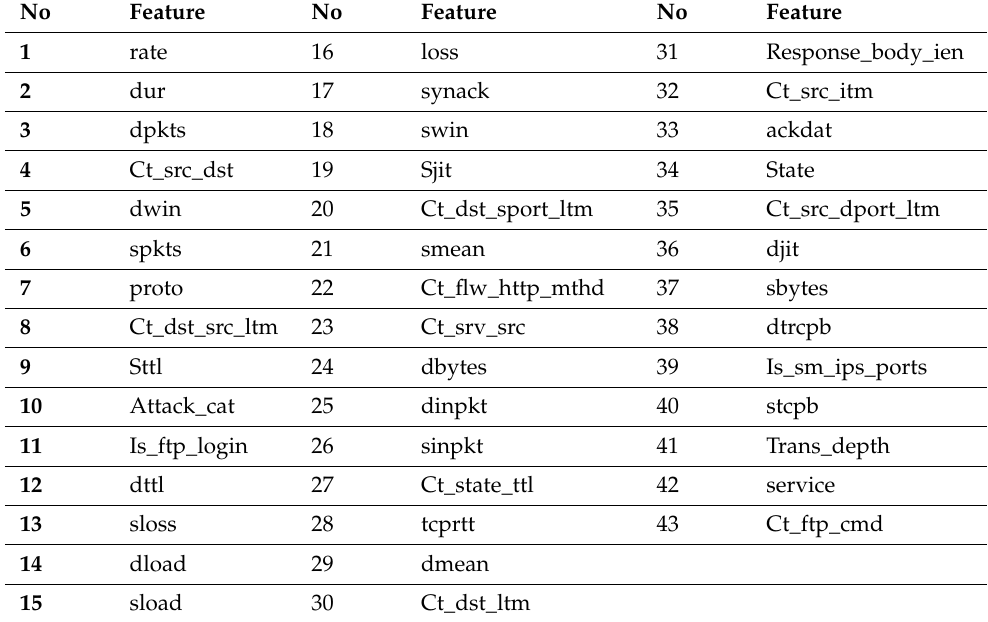
Figure 4. UNSW-NB15 data class distribution. Table 5. Features of the UNSW-NB15 dataset.